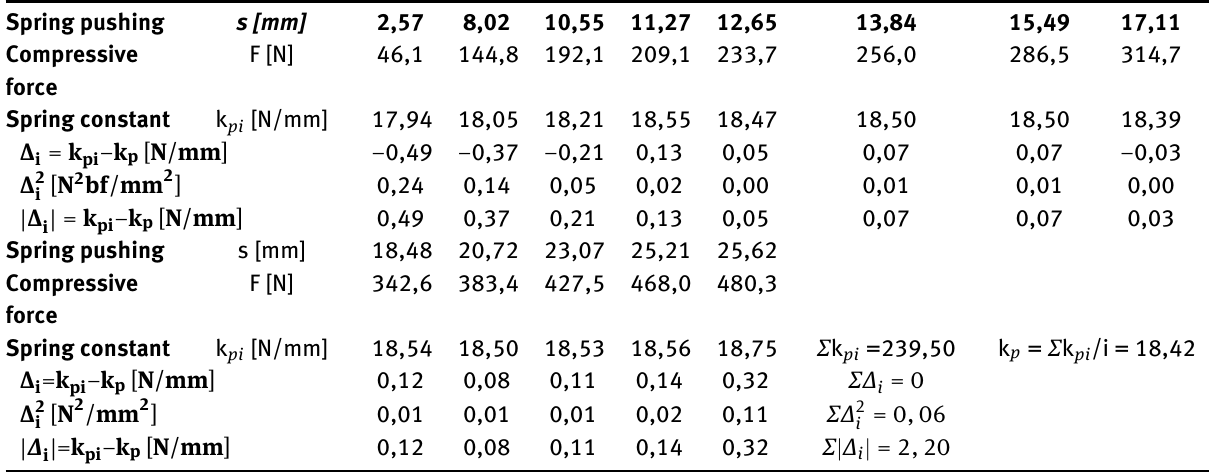
Table 1: Experimental measurement No. 1